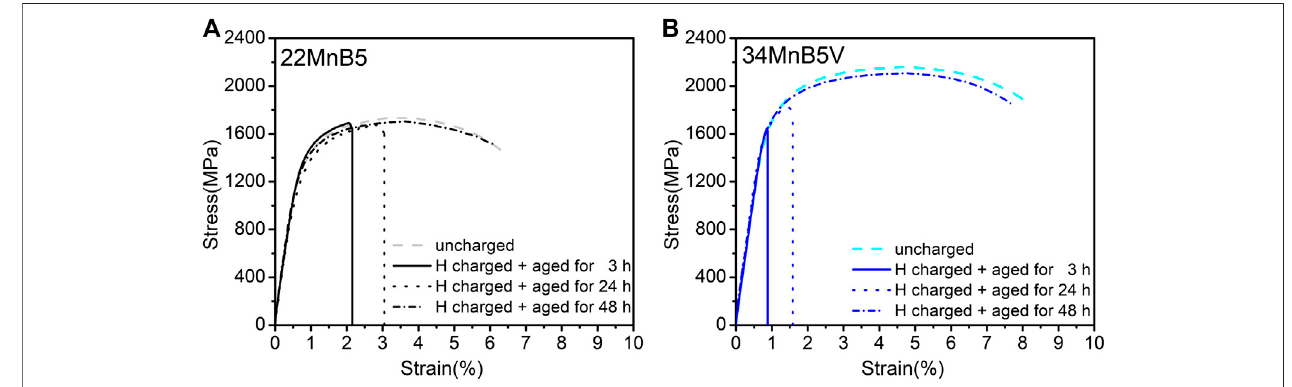
FIGURE 7 | Stress-strain curves of SSRT tests for charged and naturally aged steels: (A) 22MnB5 steel and (B) 34MnB5V steel.